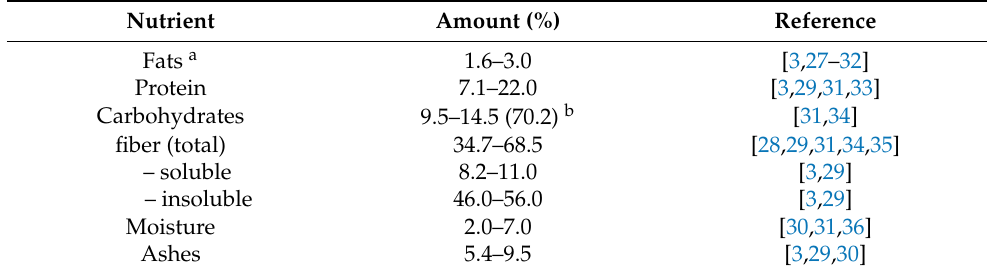
Table 1. Macro nutrients of coffee silver